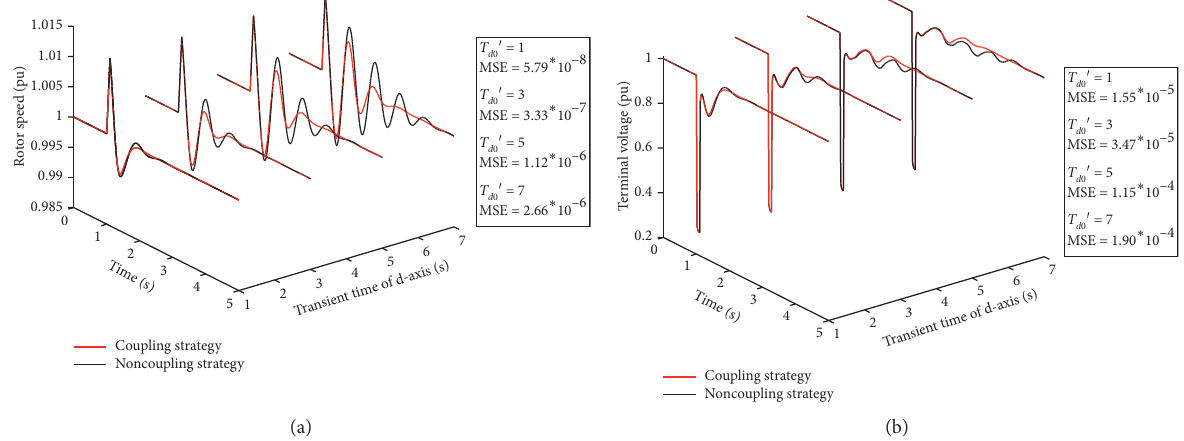
Figure 20: Response comparison under a three-phase short circuit fault condition of different transient time constants of the d-axis. (a) Rotor speed response. (b) Terminal voltage